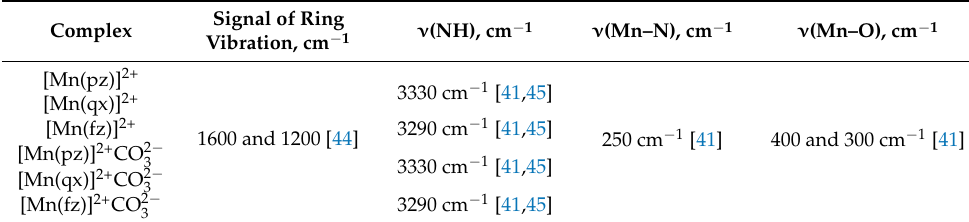
98.52% of the [Mn(fz)] 2+ CO 2 − Mn 2+ .